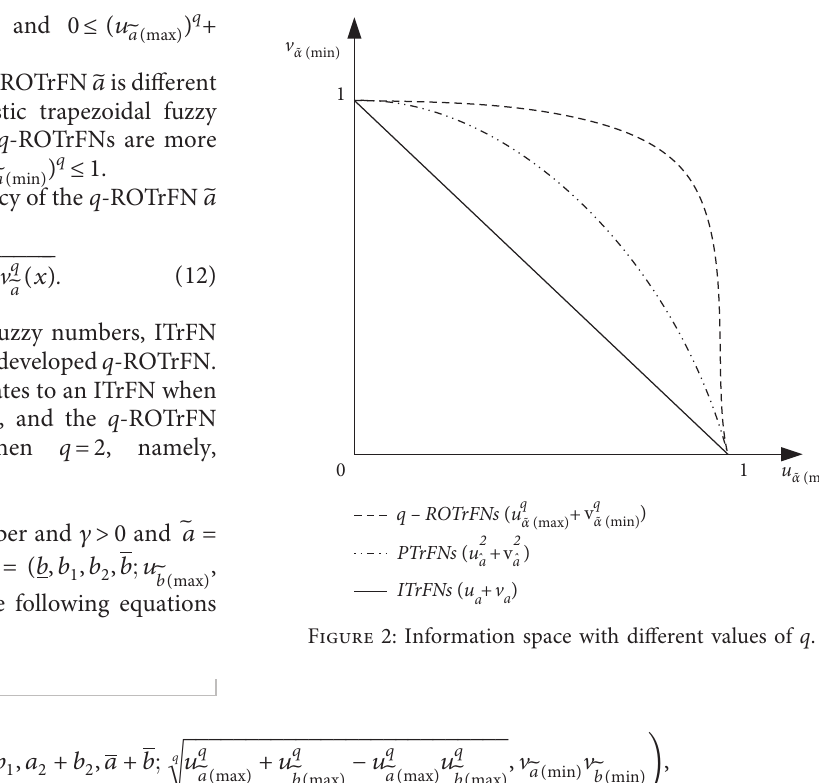
,a , a ; u 􏽥 , v 􏽥 ) . a ( max ) a ( min ) 1 2